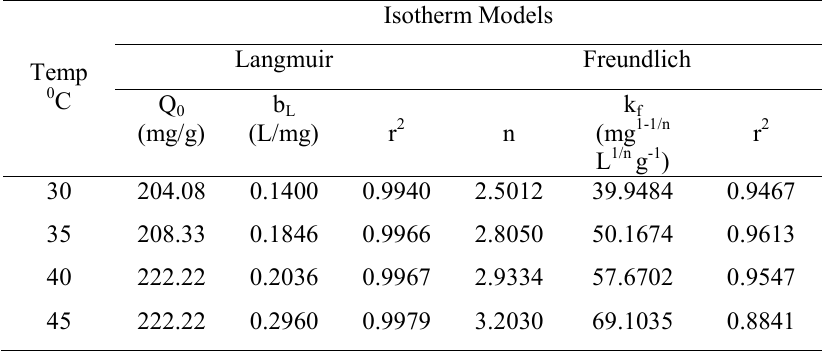
Table 3. Comparison of the coefficients of Isotherm parameters of Reactive